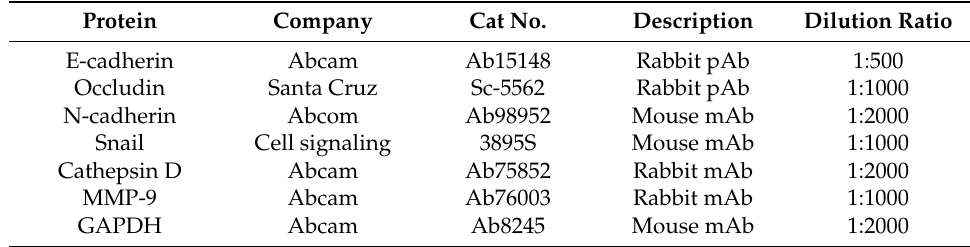
Table 1. Antibodies utilized in this